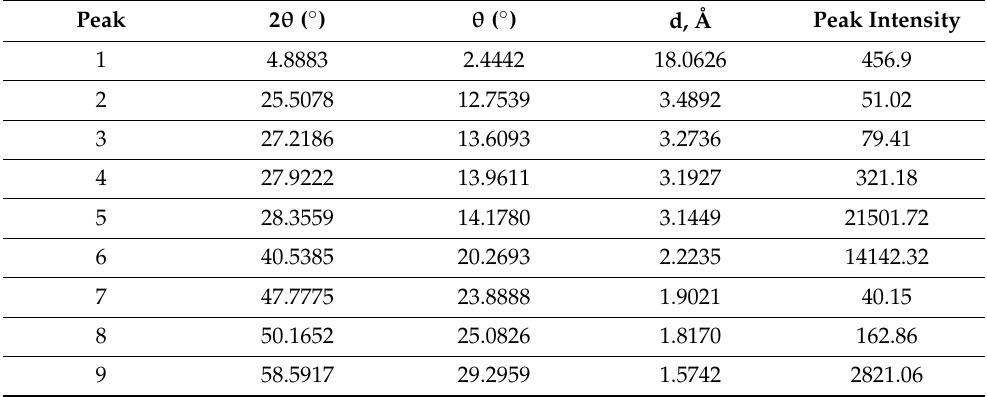
Figure 2. X-ray diffraction analysis. ( a ) Diffractograms obtained for extracts of Plantago lanceolata : Table 1. Interplanar distances obtained for the sample